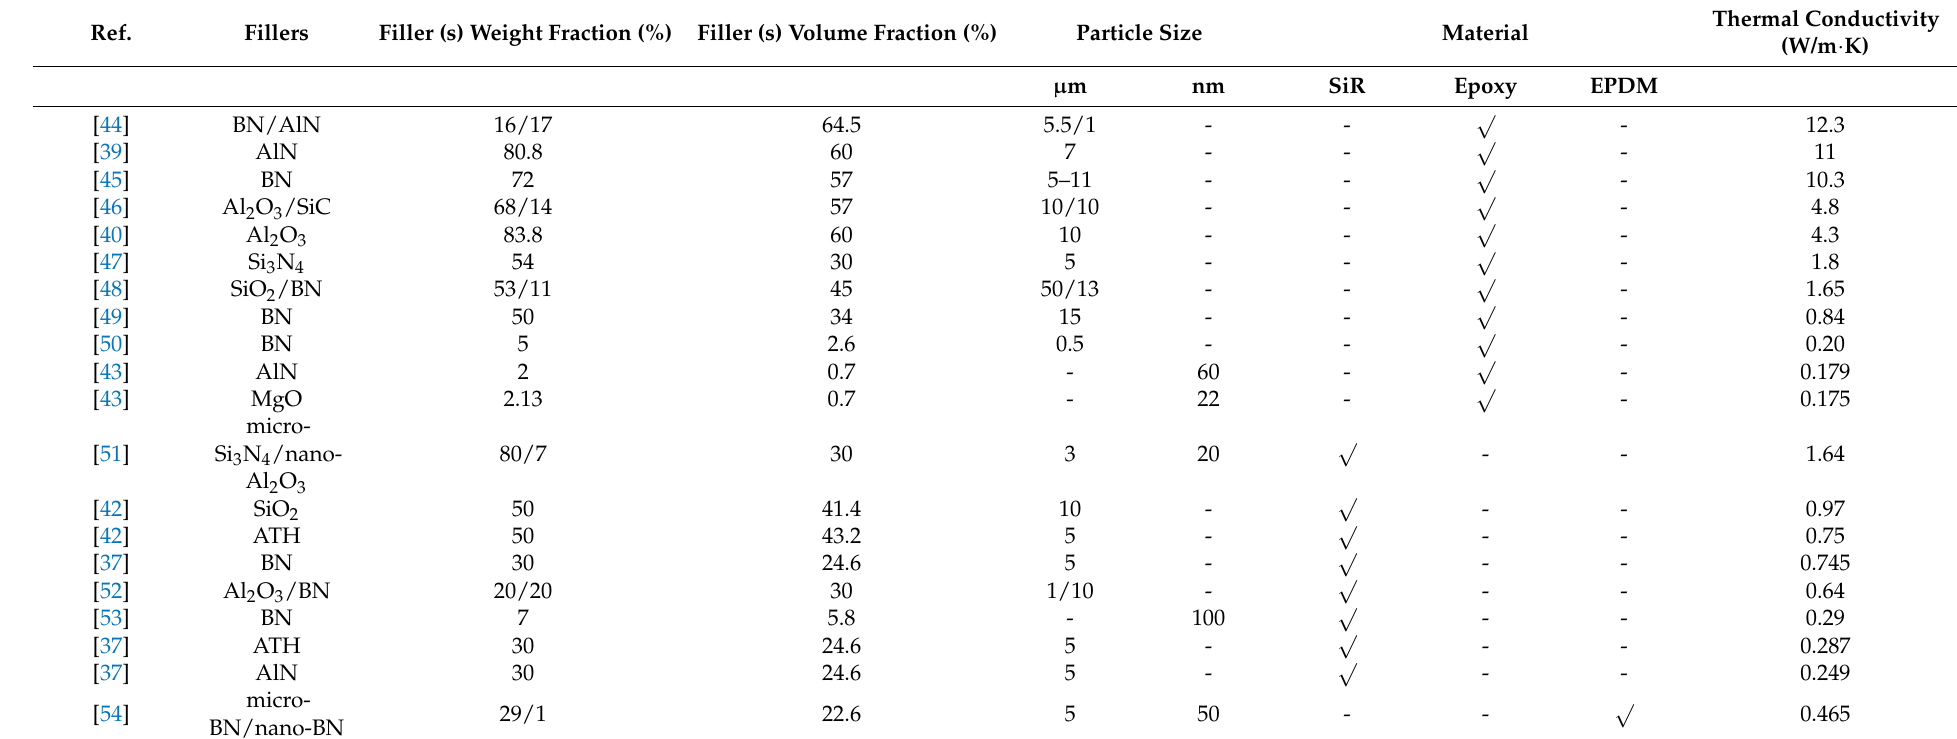
Table 2. Increased thermal conductivity of polymer matrix by adding different